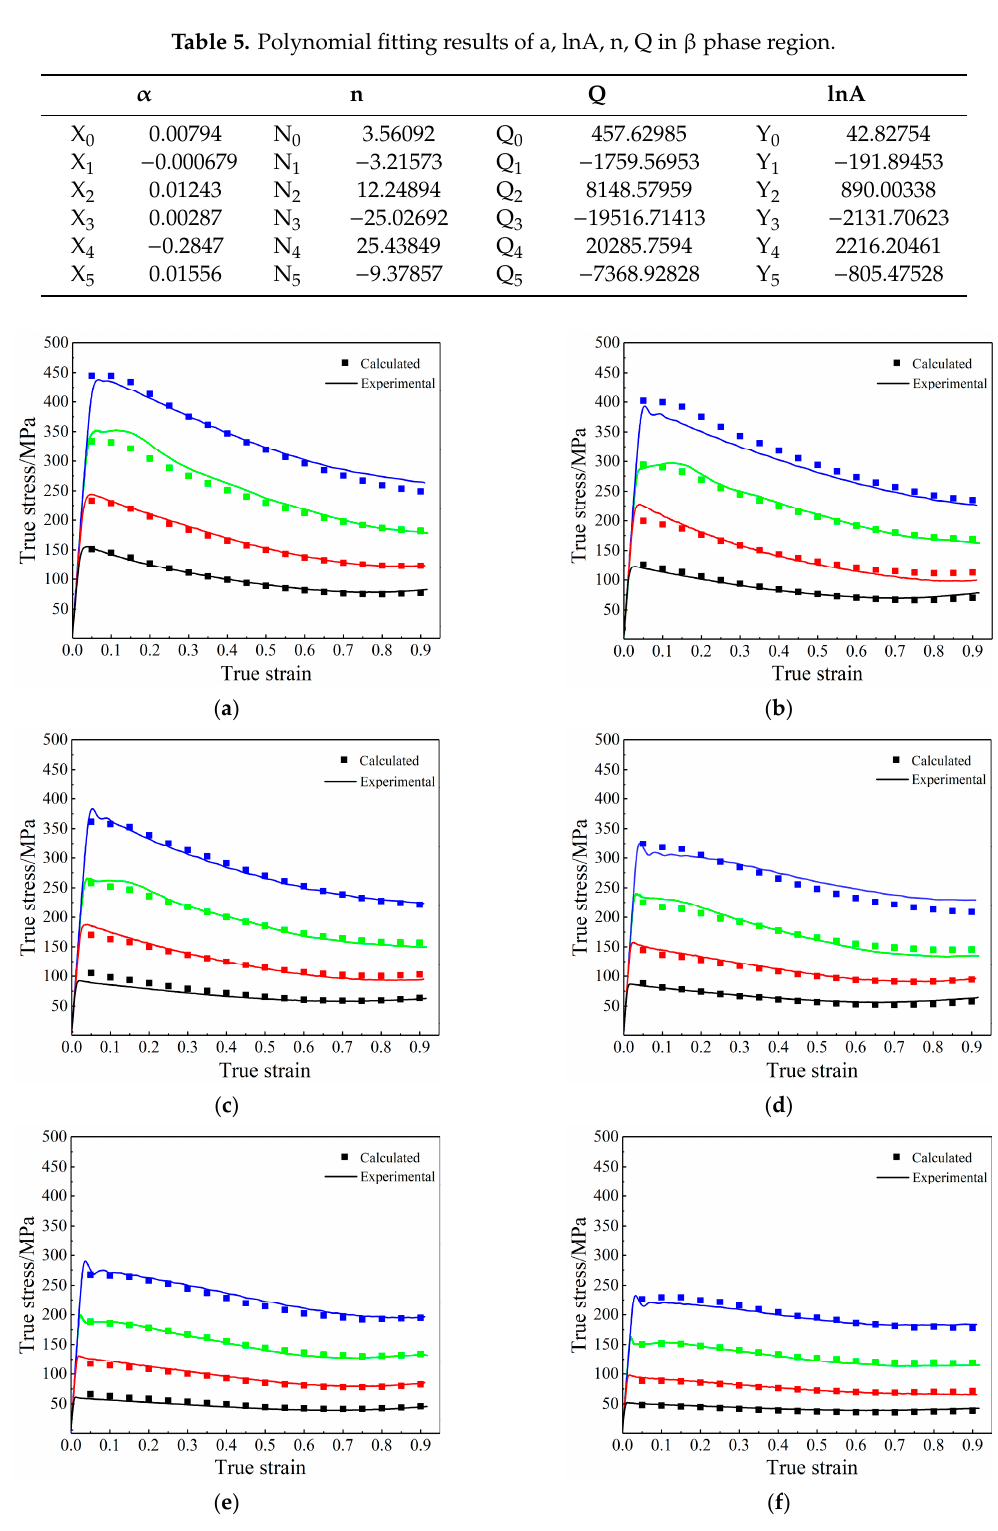
Figure 6. Comparison between experimental and model calculated flow stress at deformation temperatures of ( a ) 715 °C ; ( b ) 735 °C ; ( c ) 755 °C ; ( d ) 775 °C ; ( e ) 810 °C ; ( f ) 840 °C .